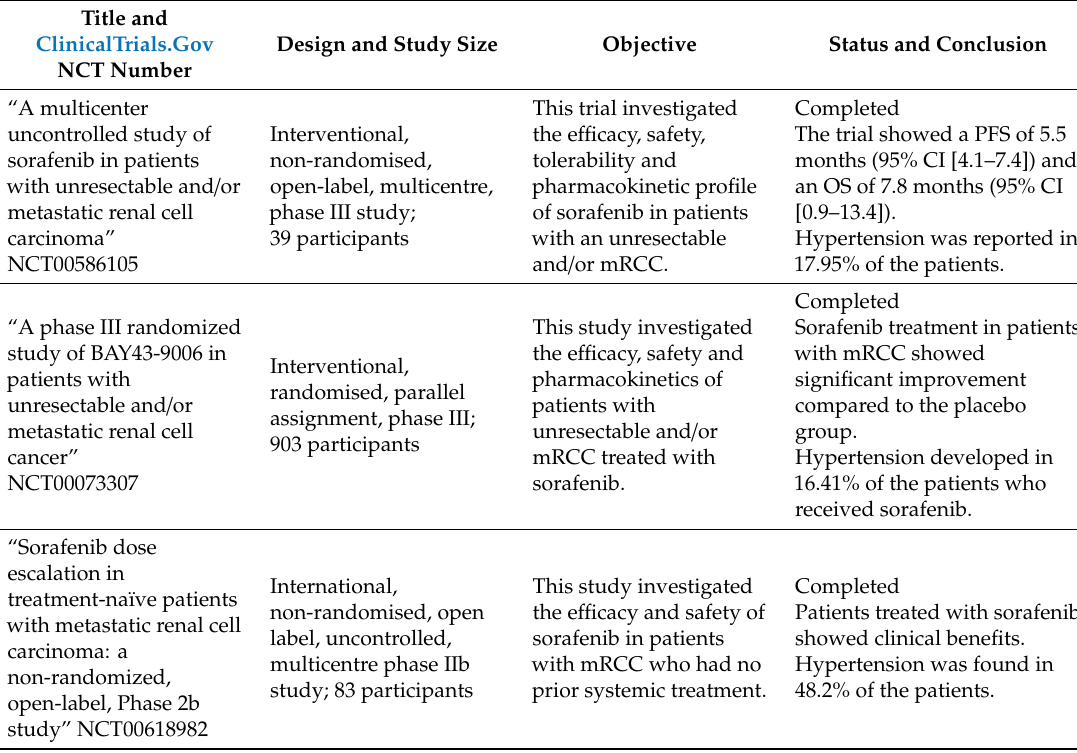
Table 5. Most recent sorafenib clinical trials for treating renal cell carcinoma